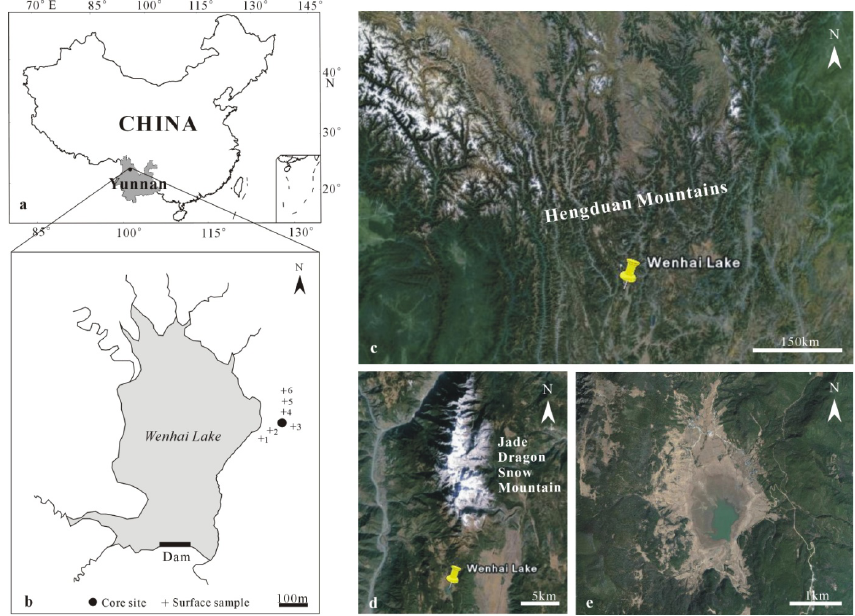
Figure 1. (a) The location of Wenhai Lake in northwestern Yunnan, China, (b) the position of core and surface soil samples, (c) the location of Wenhai Lake in the Hengduan Mountains, (d) the location of Wenhai Lake on Jade Dragon Snow Mountain, and (e) an enlarged photograph of Wenhai Lake ( c , d and e are taken from Google